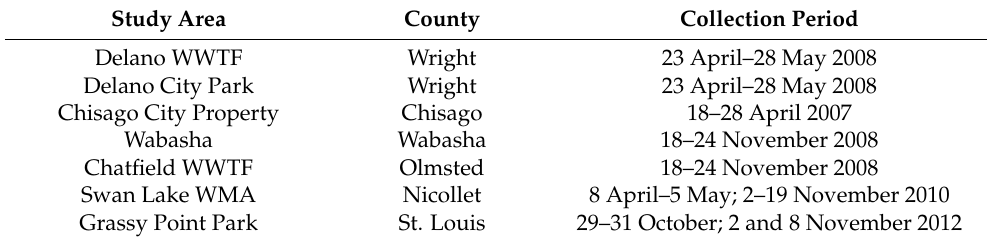
Table 2. Lidar collection periods for each study area.